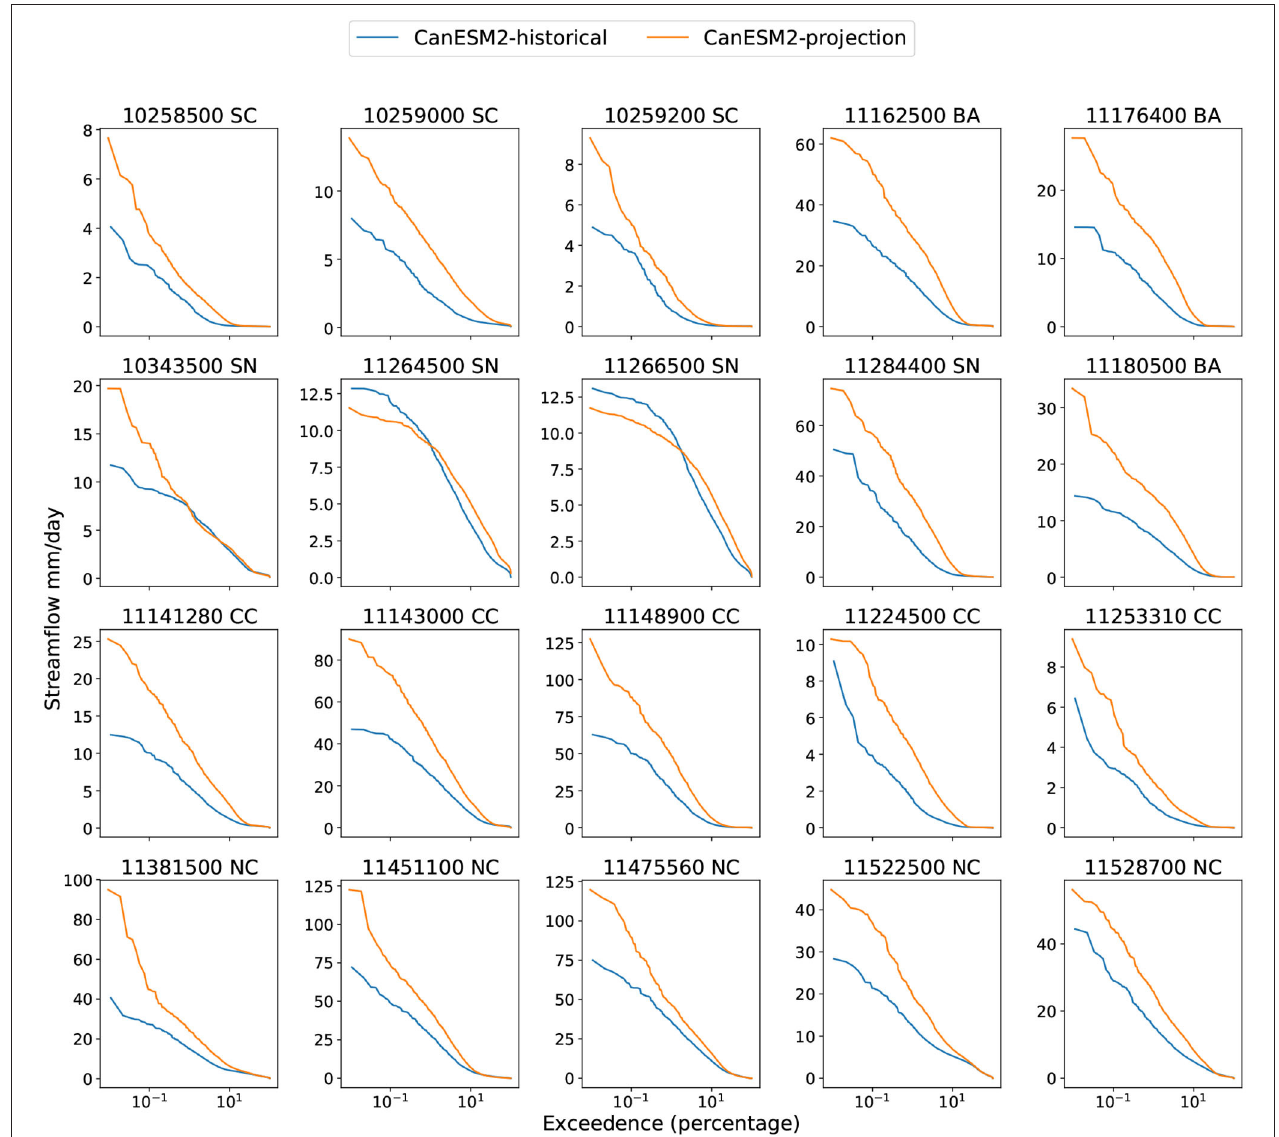
FIGURE 8 | Flow duration curve with CanESM2 forcing over both historical and future (projection)